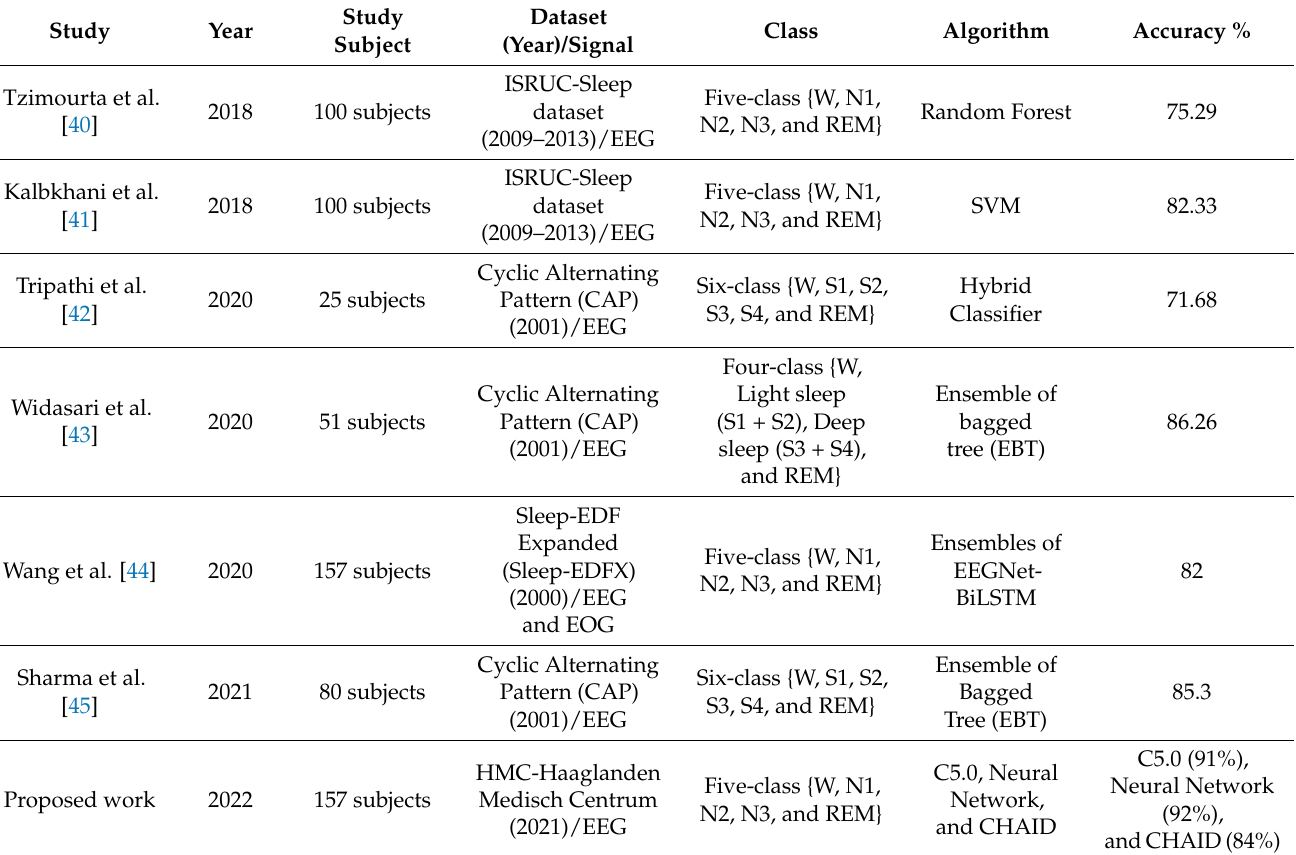
Table 10. Comparative analysis of the methods and outcomes of the proposed work with other sleep